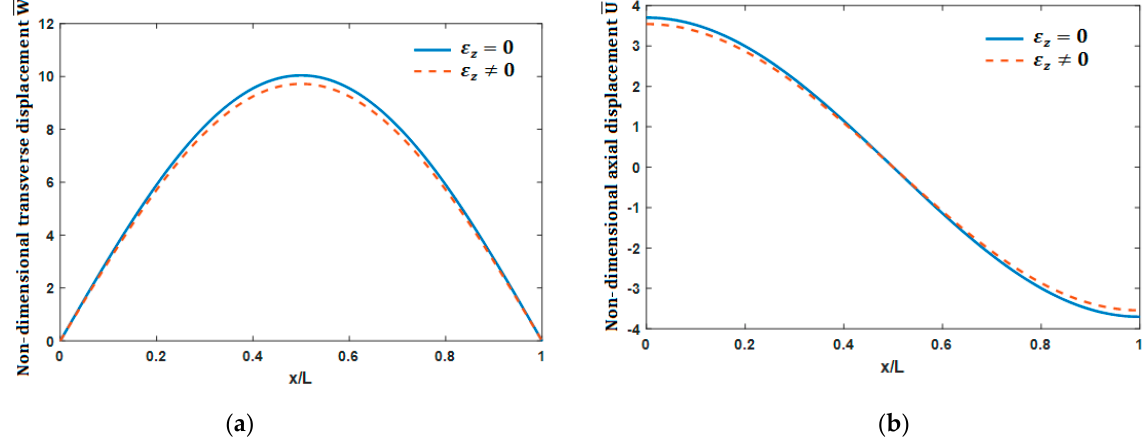
Figure 4. Thickness stretching effect on the non-dimensional transverse ( a ) and axial displacements ( b ).